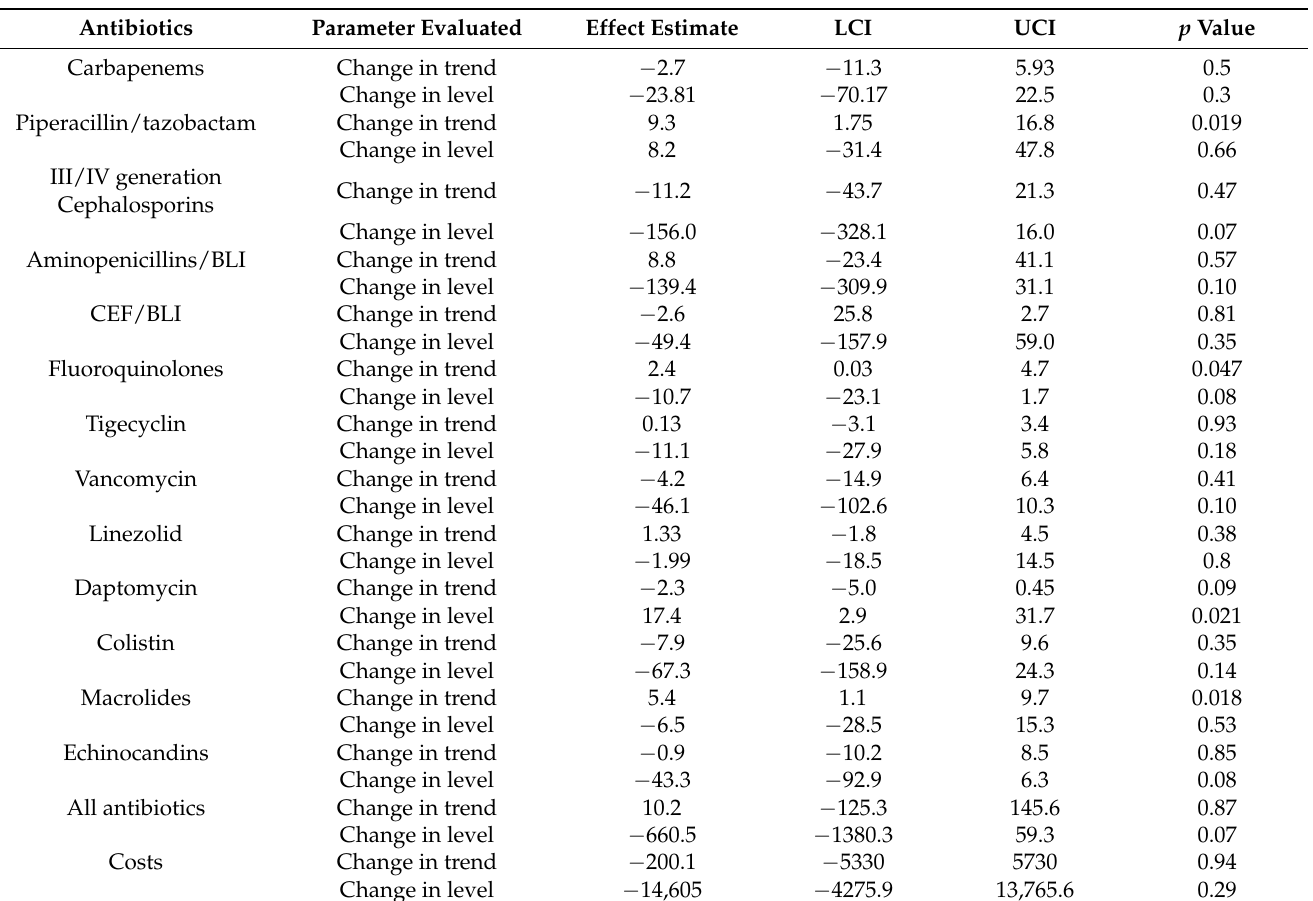
Table 3. Effect of the ASP interruption during COVID-19 pandemic on antibiotic consumption in the 2 ICUs included in the